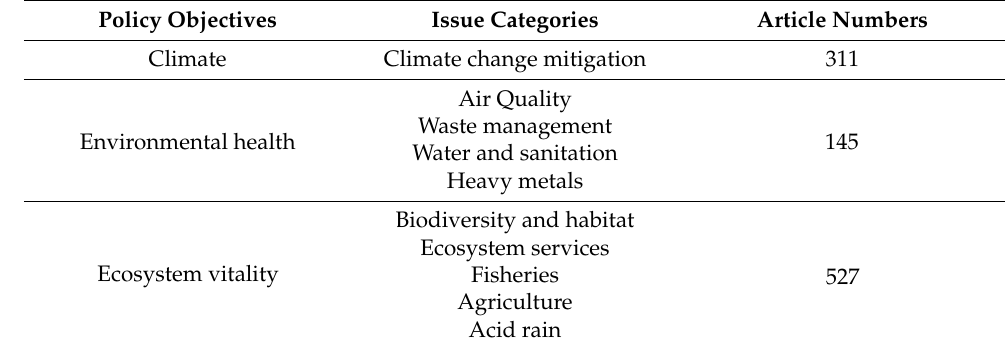
Table 2. Literature screening with the EPI framework.